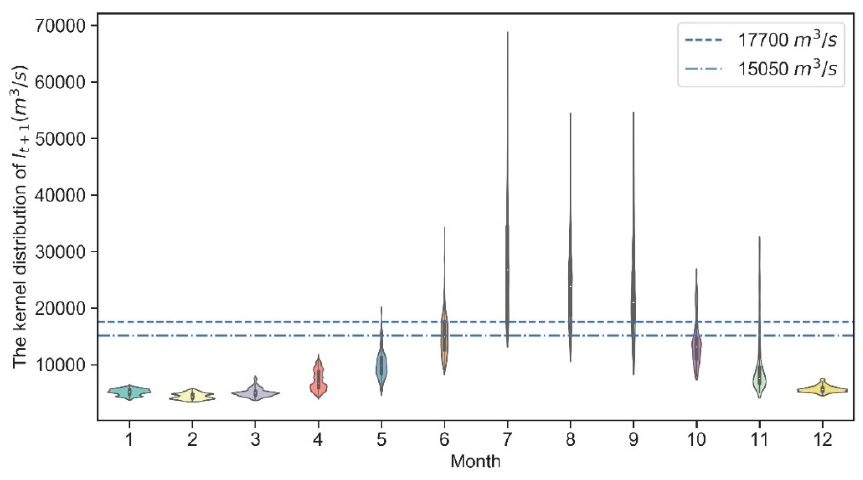
Figure 6. The kernel distribution of forecasted 1-day inflow in different months.